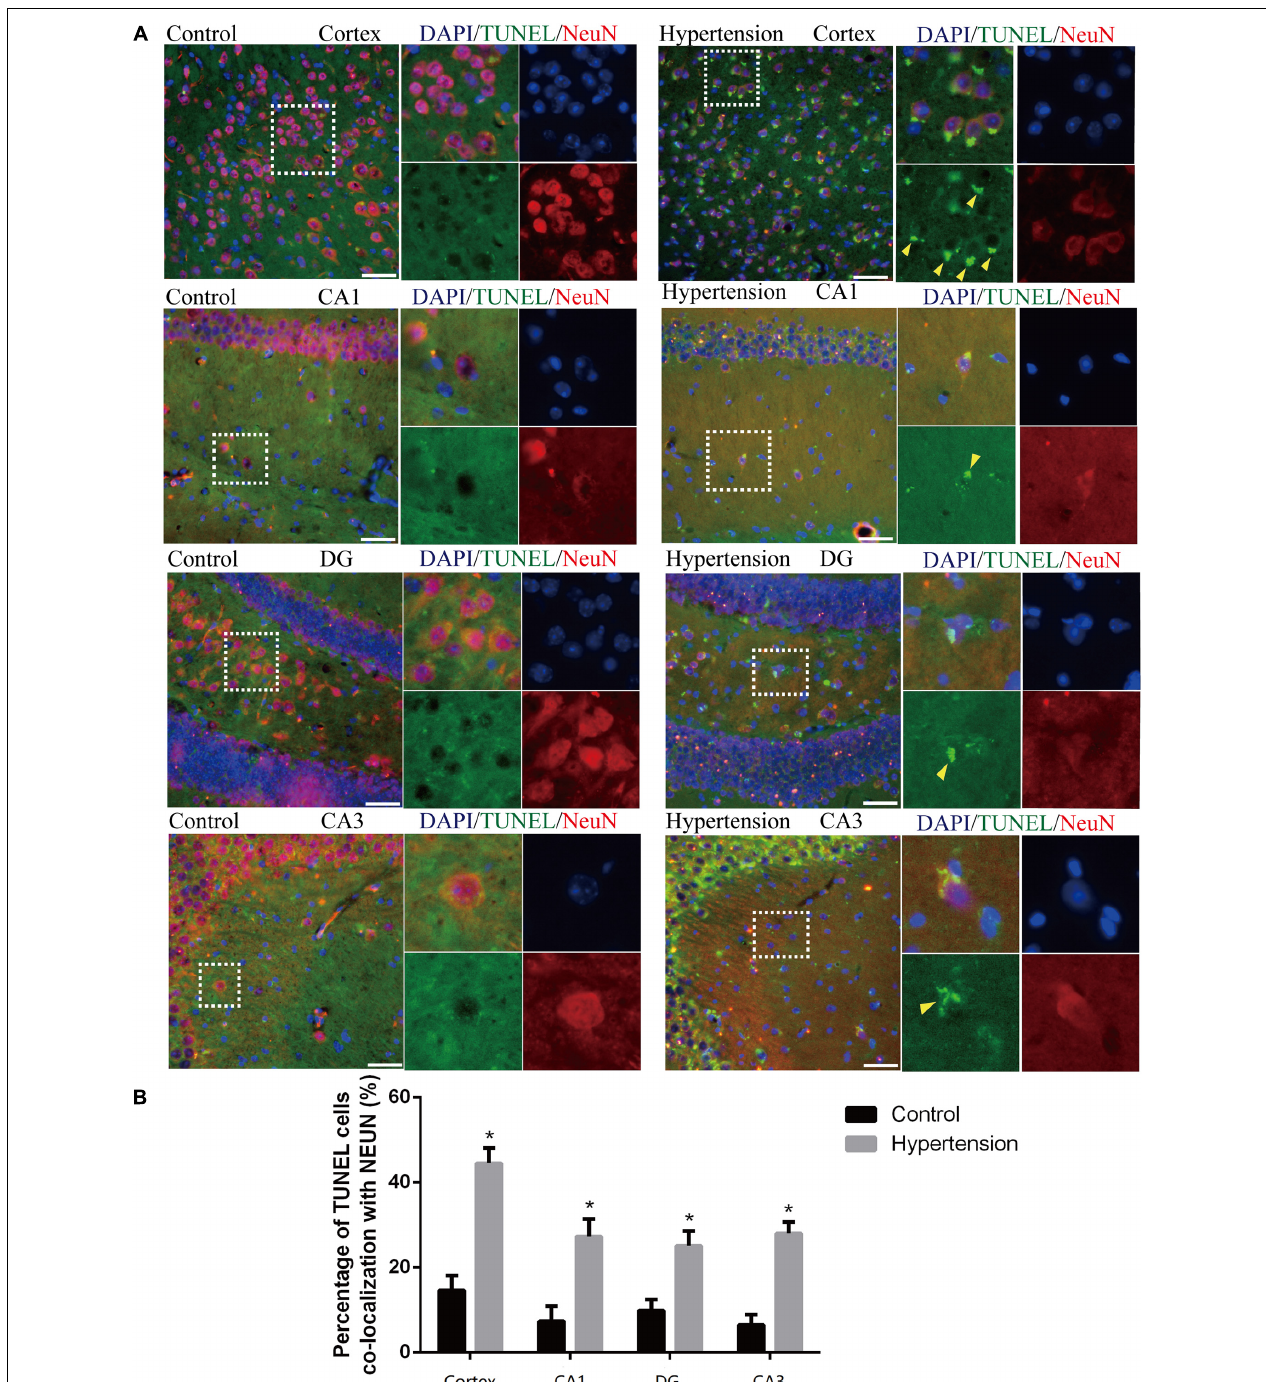
FIGURE 3 | Angiotensin II-induced hypertension promotes neuronal apoptosis in middle-aged mice. (A) Representative images of TUNEL-positive, fluorescein-labeled (green) neurons co-stained with the anti-NeuN antibody (red) in the cortex and hippocampus (CA1, DG, and CA3) of mice in the control and hypertension groups (immunofluorescence, × 20, scale bar = 50 µ m). (B) Histograms comparing the level of positive TUNEL staining in neurons in the cortex and hippocampus (CA1, DG, and CA3) of mice in the control and hypertension groups. Data are expressed as the means ± SD. * p < 0.05. (Negative control image of TUNEL staining assay provided in Supplementary Figure 3